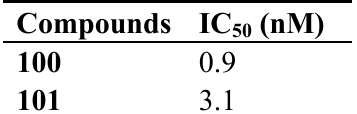
Table 8. Summary of the inhibitory potencies (IC